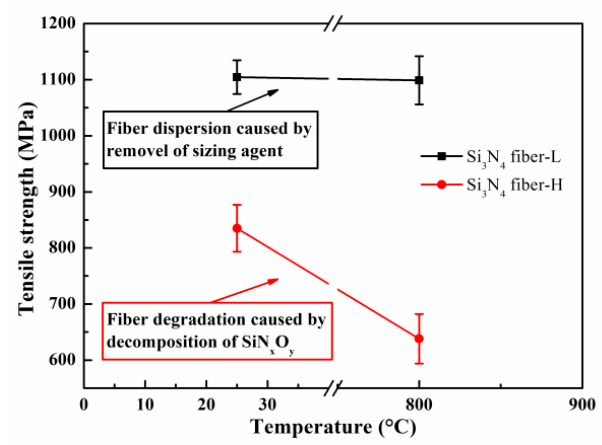
Figure 10. Single tow tensile test results.